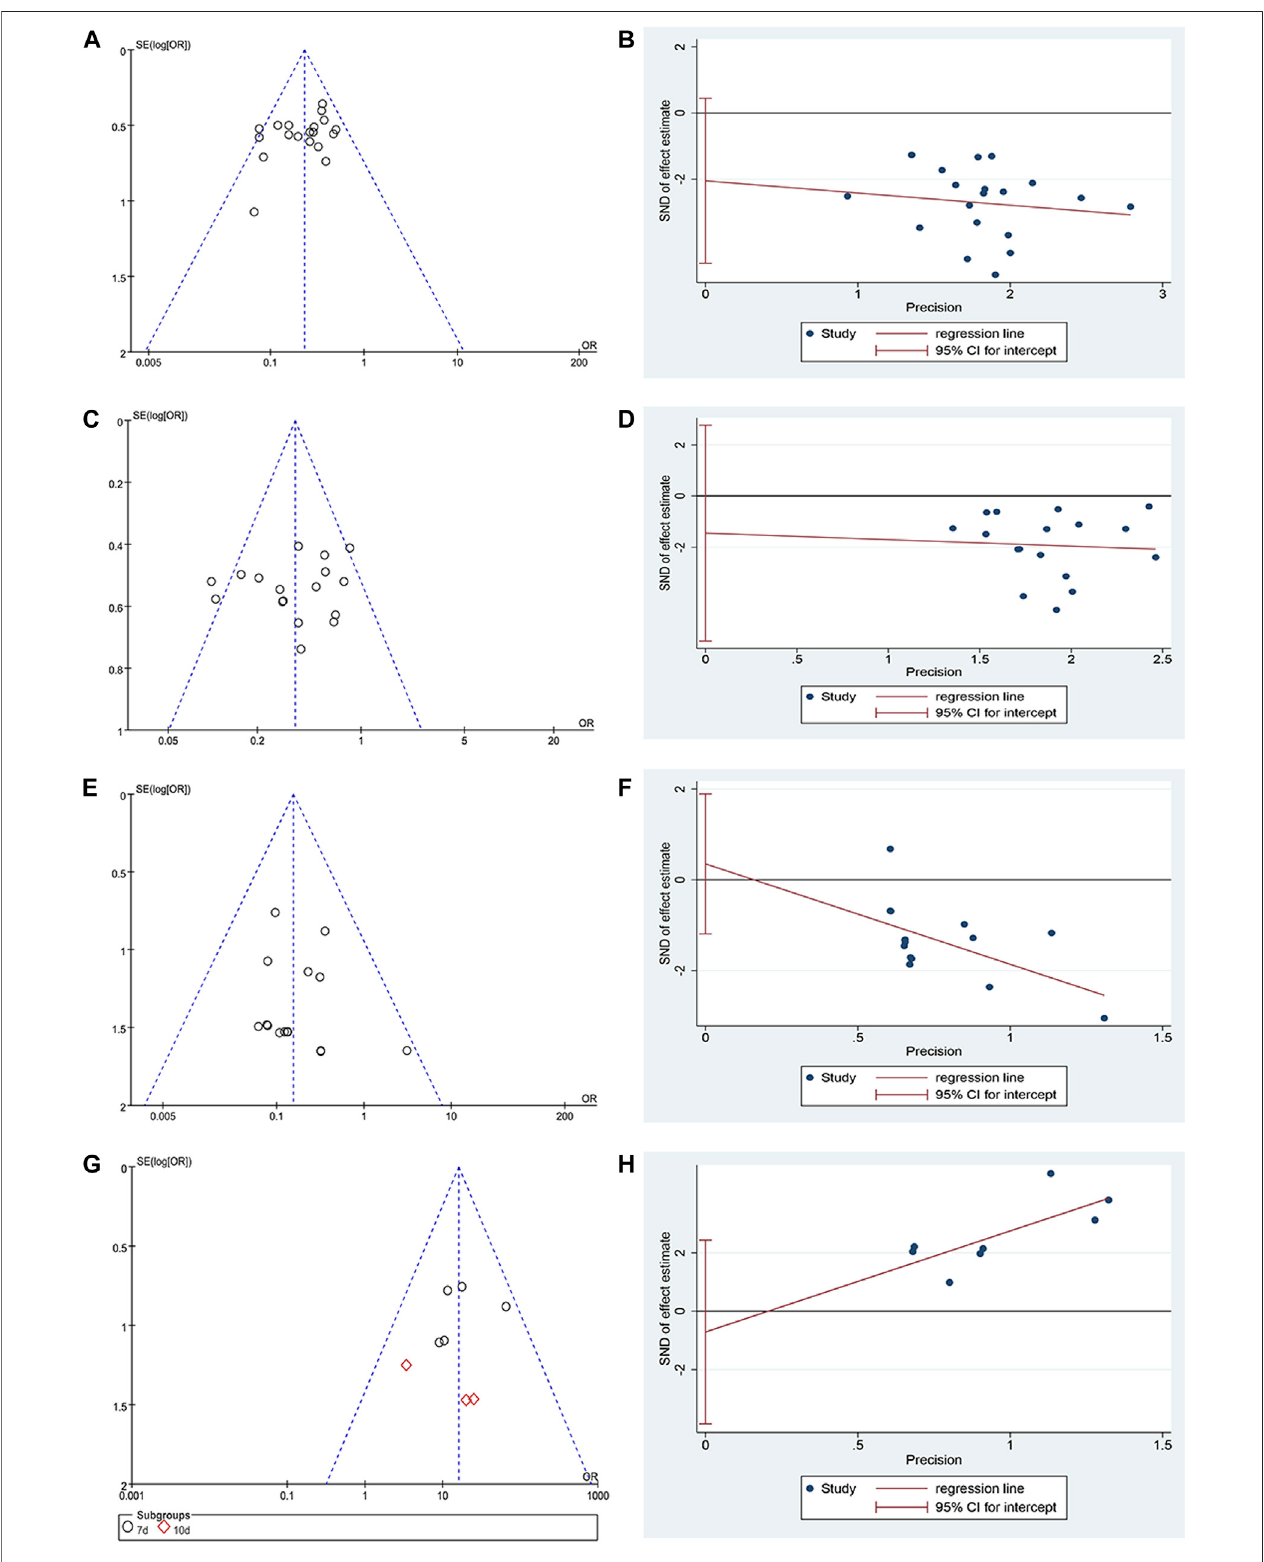
FIGURE 7 | Publicationbiasplots. (A) FunnelplotofincidenceofCIOM; (B) Egger ’ splotofincidenceofCIOM; (C) FunnelplotofgradeI – IICIOM; (D) Egger ’ splotofgradeI – II CIOM; (E) Funnel plot of grade III – IV CIOM; (F) Egger ’ s plot of grade III – IV CIOM; (G) Funnel plot of effective rate of CIOM; (H) Egger ’ s plot of effective rate of CIOM.